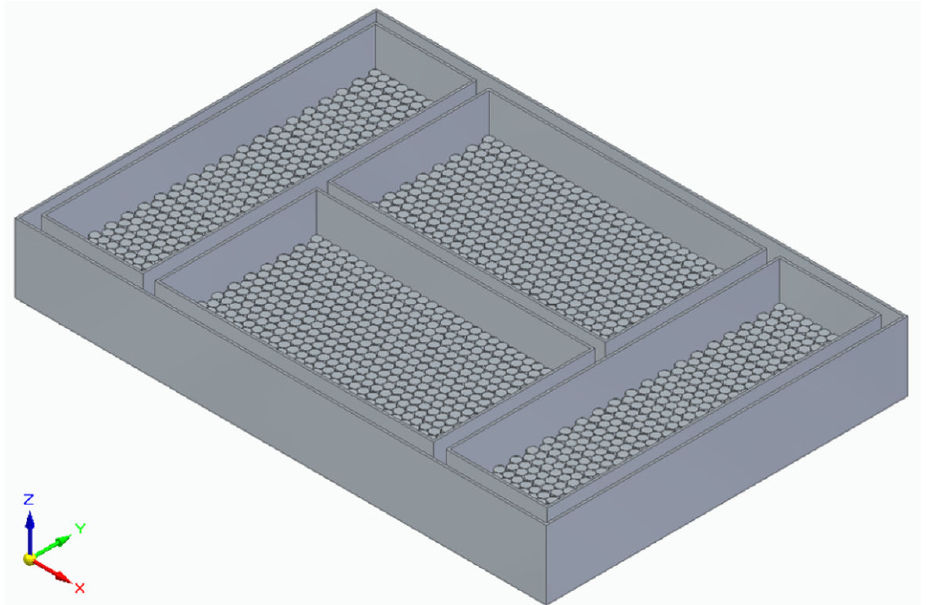
Figure 12. CAD model of the optimal configuration (Configuration 7 with 21700 Panasonic cylindrical cells, arranged in four modules with an offset